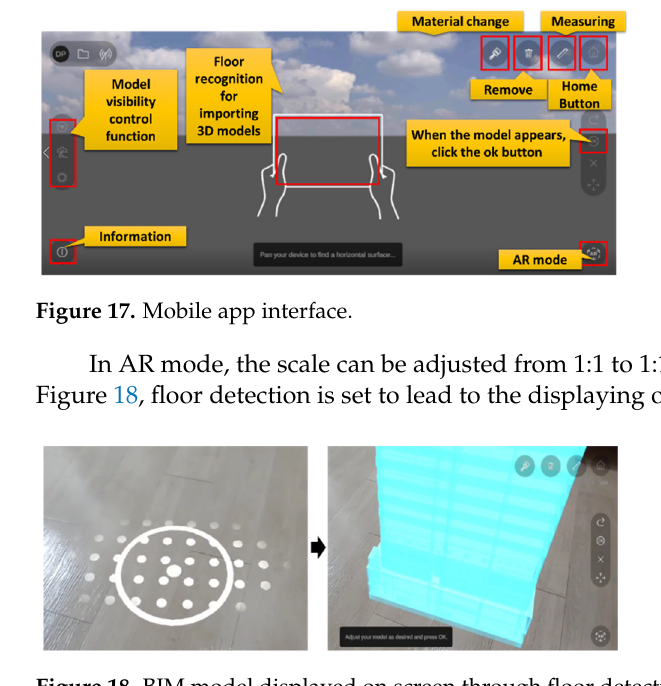
Figure 16. Results extracted to excel through reporting.